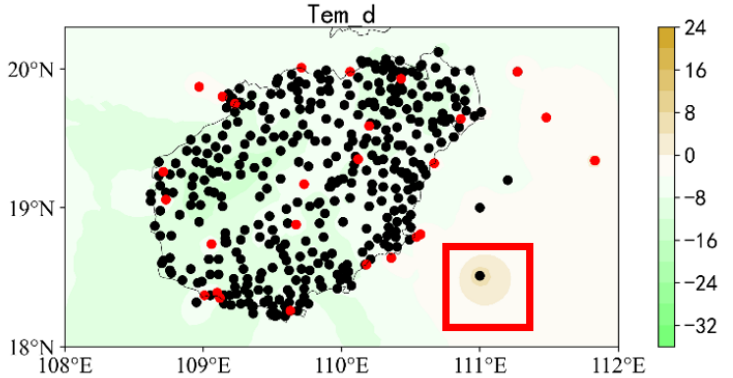
Figure 2. Distribution of correlation coefficients between hourly temperature differences and hourly precipitation in Hainan Province, from September 2020 to August 2021 (black and red dots as shown in Figure 1).